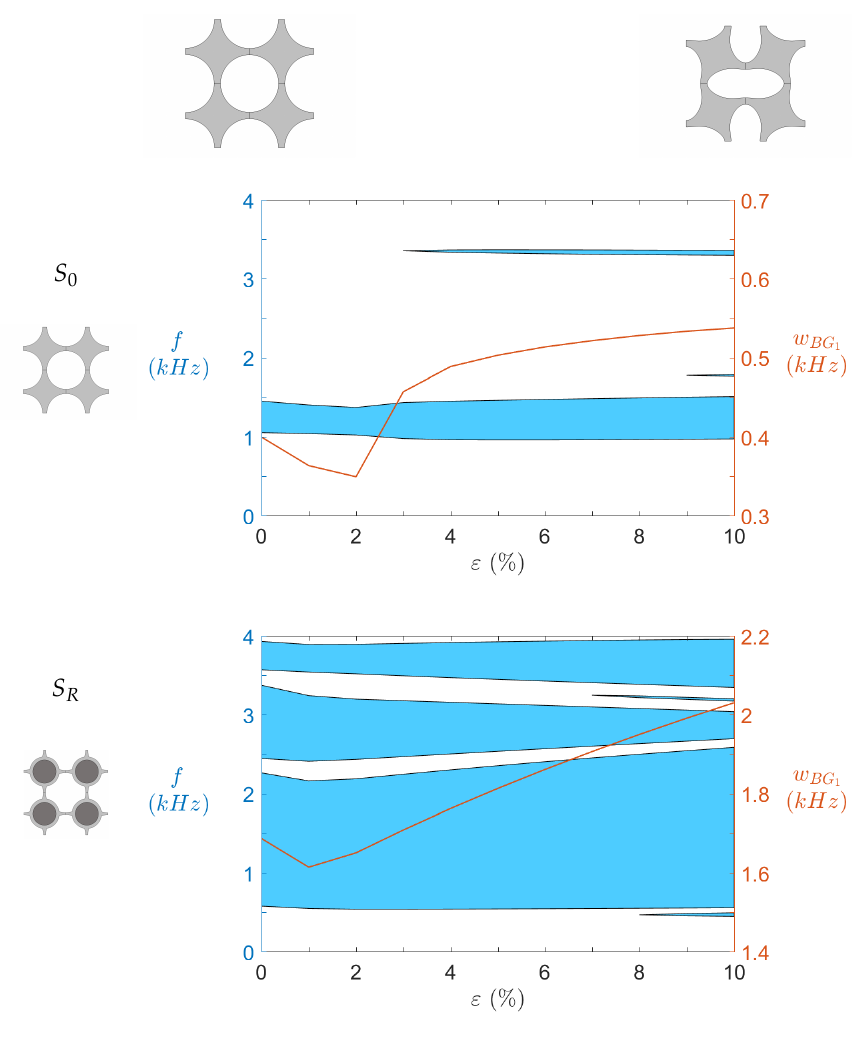
Figure 11. Evolution of omnidirectional bandgap ranges as function of imposed static strain for both geometries. Bandgaps and width w BG